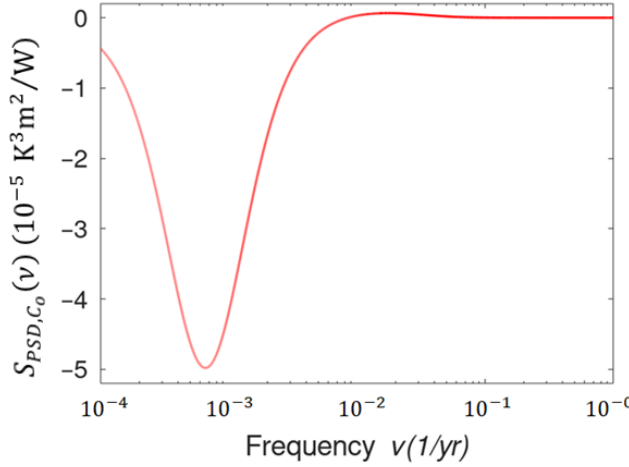
Figure 10. Sensitivity function of power spectral density of the global mean surface temperature fluctuations with respect to the deep ocean thermal inertia, determined by the effective heat capacity C o . Sensitivity function of power spectral density of GMST fluctuations with respect